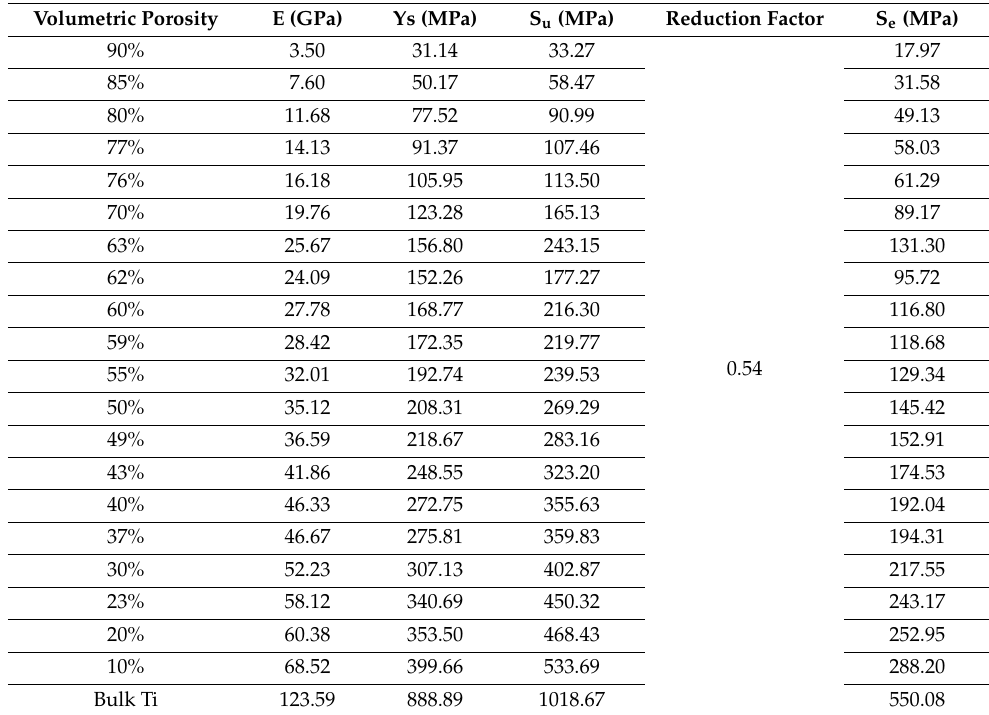
Table 4. The obtained elastic moduli, yield strength, ultimate tensile strength, and the associated calculated of the endurance limit S e values based on the percentage of reduction in S u due to the introduced